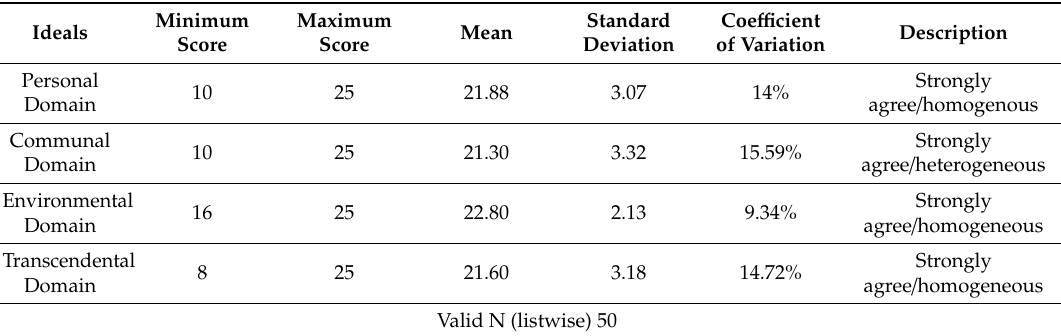
Table 2. Results of the ideals for spiritual health survey.